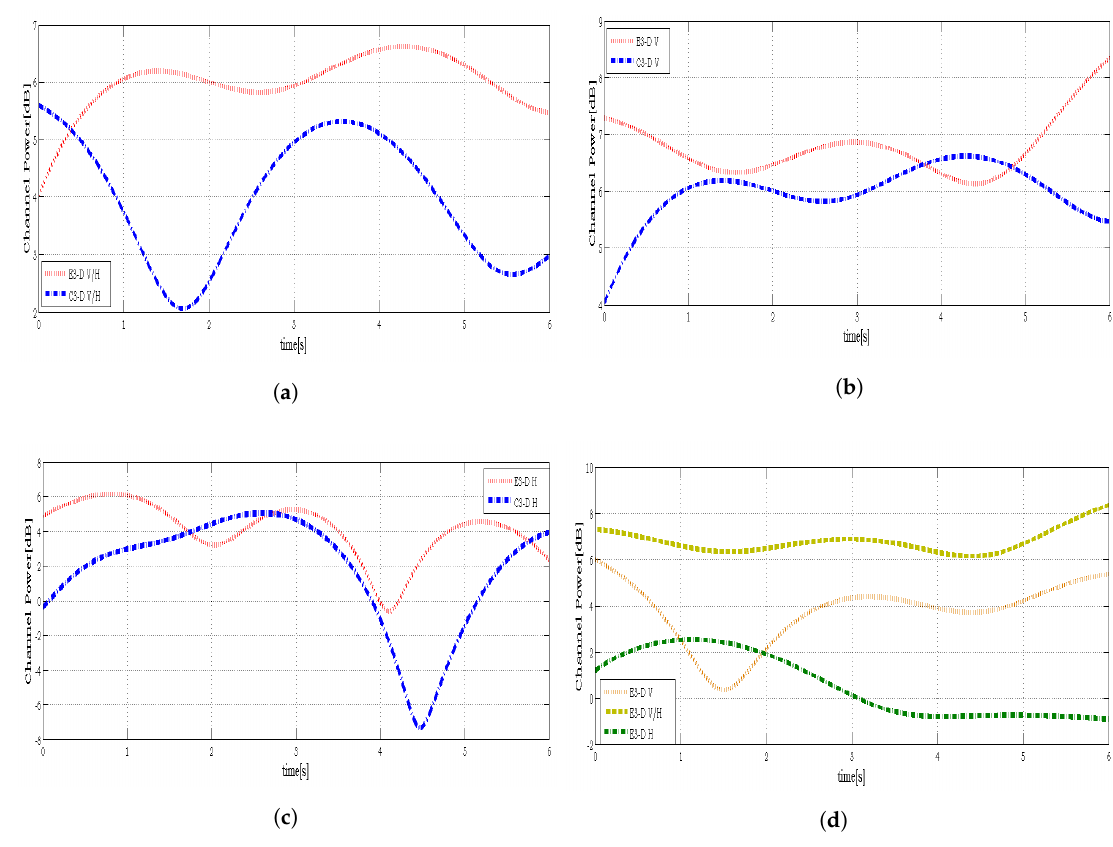
Figure 5. Performance comparison between E3-D and C3-D models based on different configurations, ( a ). V/H, ( b ). V, ( c ). H, receiving signals from TX with cross antenna elements polarization toward RX, in case there are polarization matching between TX and RX. And ( d ), in case there are polarization mismatching between TX and RX, the channel variations are based on the user movement with different DoT = 0 ◦ and DoT = 90 ◦ . It is illustrated that the channel has been changed when the distance is increasing and also, the signal orientations do not match with the antenna polarization at the RX. Therefore, variation in polarization causes changes in the received signal level due to the inability